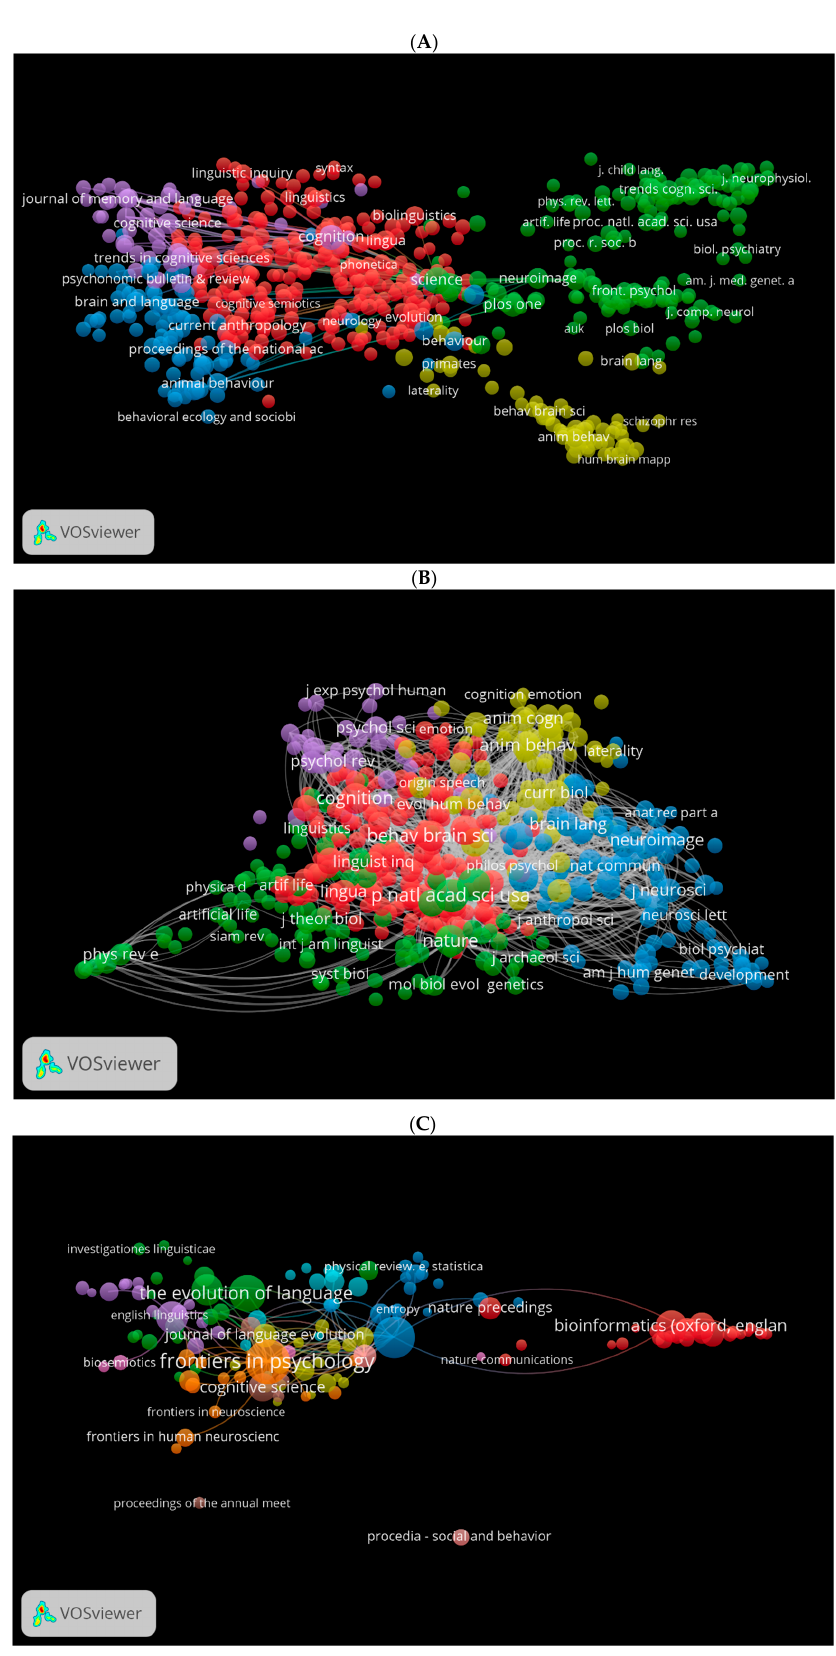
Figure 12. Co-citation by source network visualisation in biolinguistics. ( A ) (Scopus), ( B ) (WOS), ( C ) (Lens) citation by source network visualisation. Using the bibliometric data provided in Scopus, WOS, and Lens, we exported the citation reports and reported the top 10 cited works (Table 3). Based on the database, it is evident that the top cited sources vary. After merging the top 10 sources from each data- base, 20 sources are provided instead of 30. Particularly, the sources listed in Lens differ from those in Scopus and the WOS, and this may be due to their restricted inclusion cri- teria. Furthermore, the sources from Lens contained a greater number of citations. As an example, Scopus’ number two citation in biolinguistics has only 949 citations as compared to Lens’ 1825. In all fairness, it can be observed that all of these top-cited works have some connection to biolinguistics. Table 3. Top cited documents of biolinguistics based on citation reports from Scopus, WOS and Lens. No. Source Title